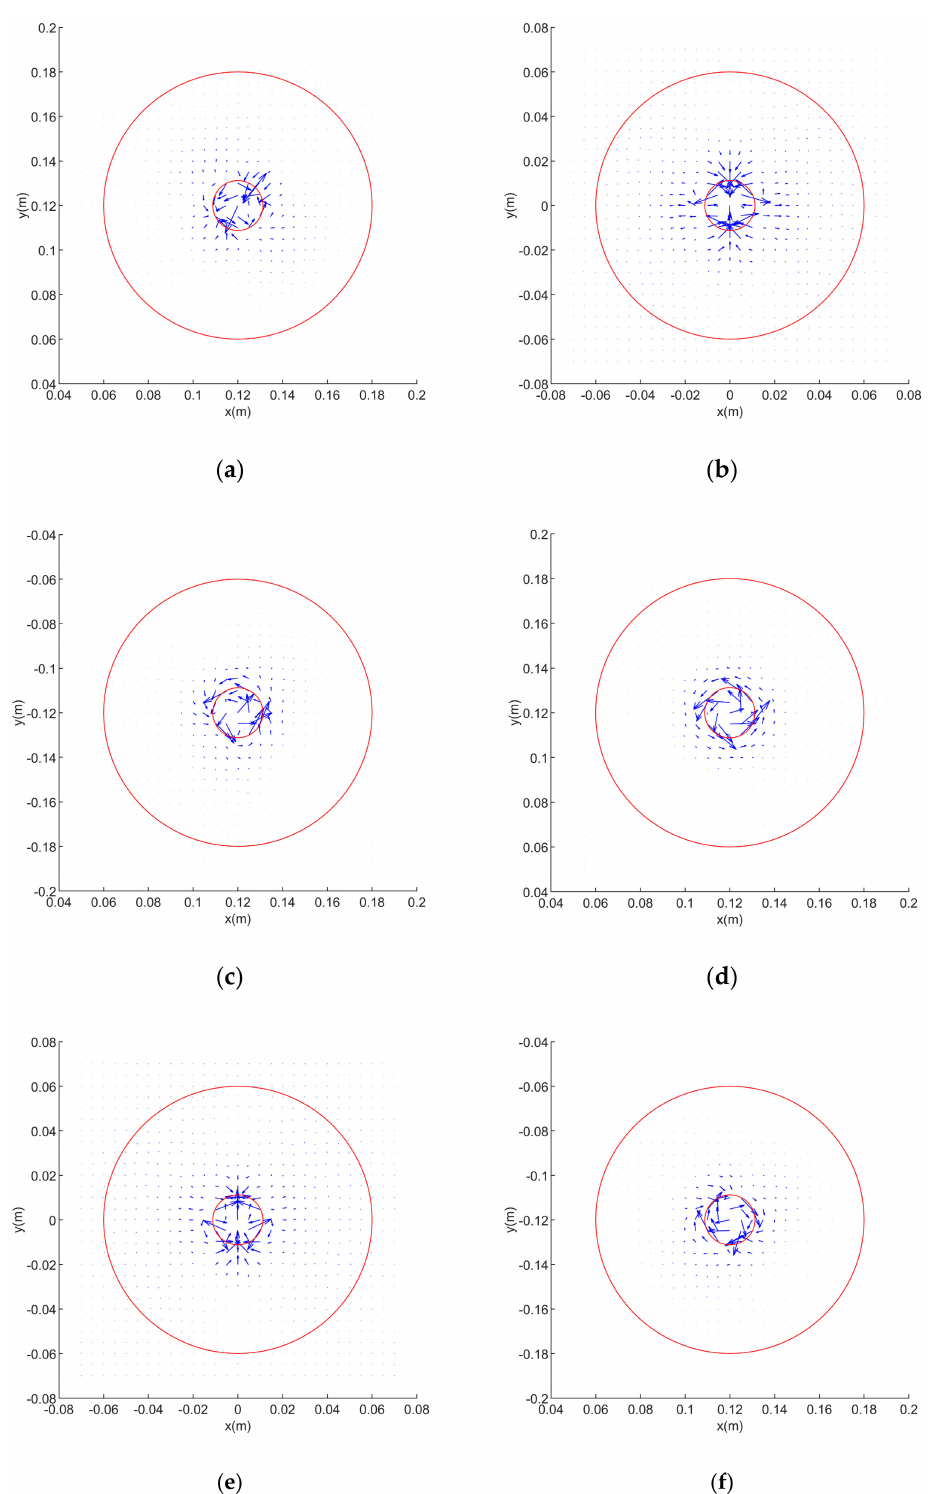
Figure A1. Power flow transmission graphs at an excitation frequency of 1000 Hz in x–y